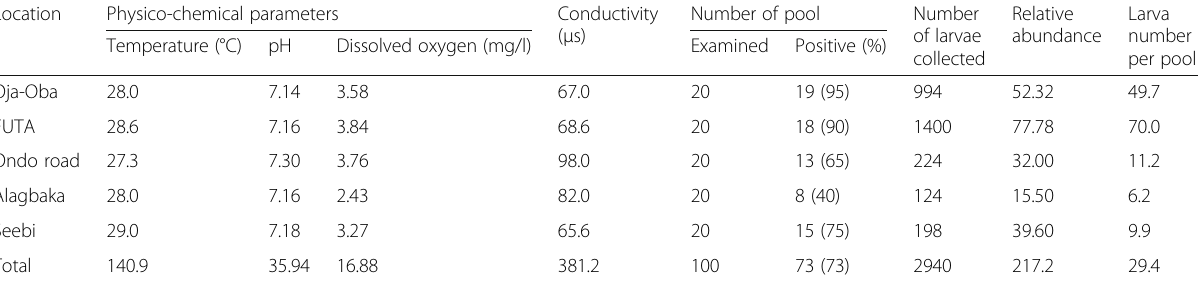
Table 2 Relative abundance of mosquitoes in relation to physico-chemical parameters of the breeding sites in Akure South Local Government Area